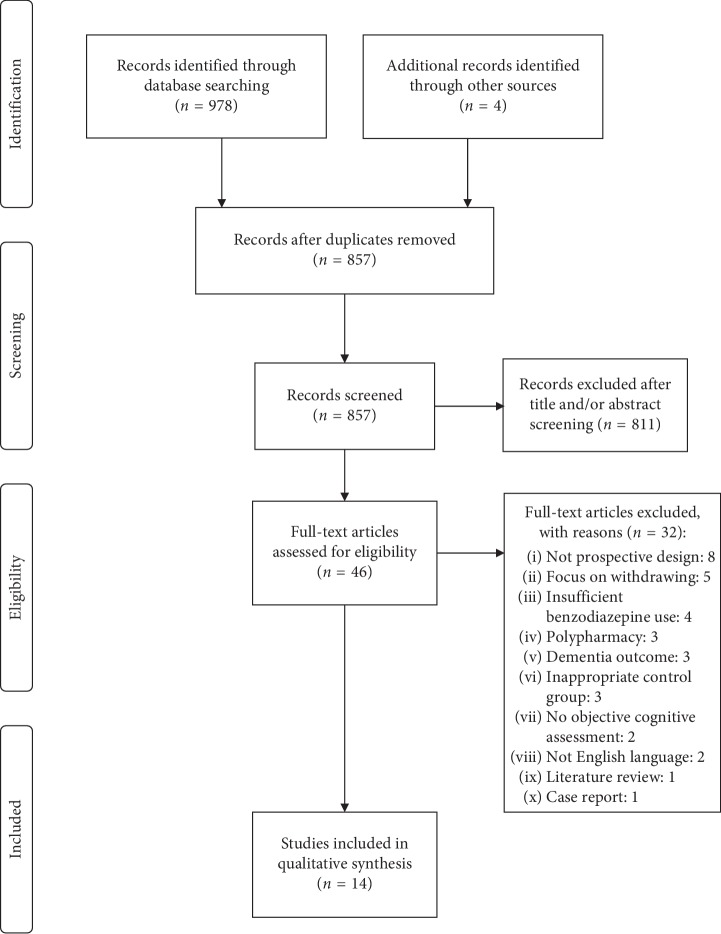
PRISMA flow diagram.